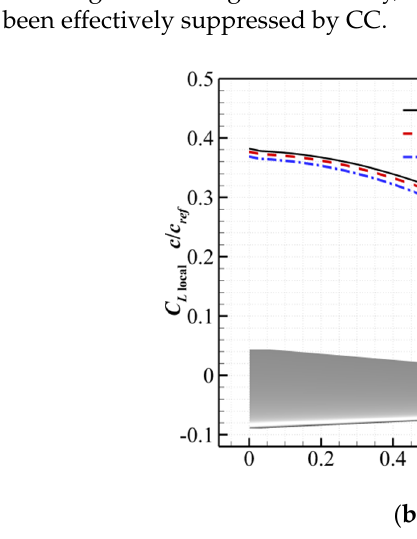
Figure 7. The influence of spanwise load distributions due to CC jet blowing. ( a ) M ∞ = 0.3 ; ( b ) M ∞ = 0.7 .